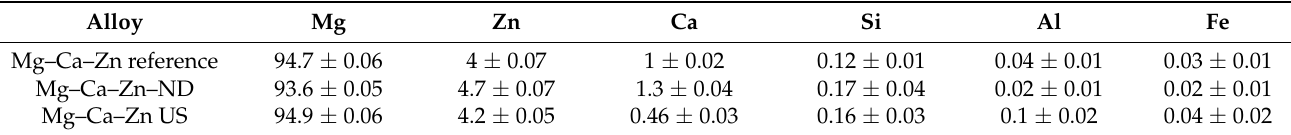
Table 1. Chemical composition (wt %) of the obtained alloys.